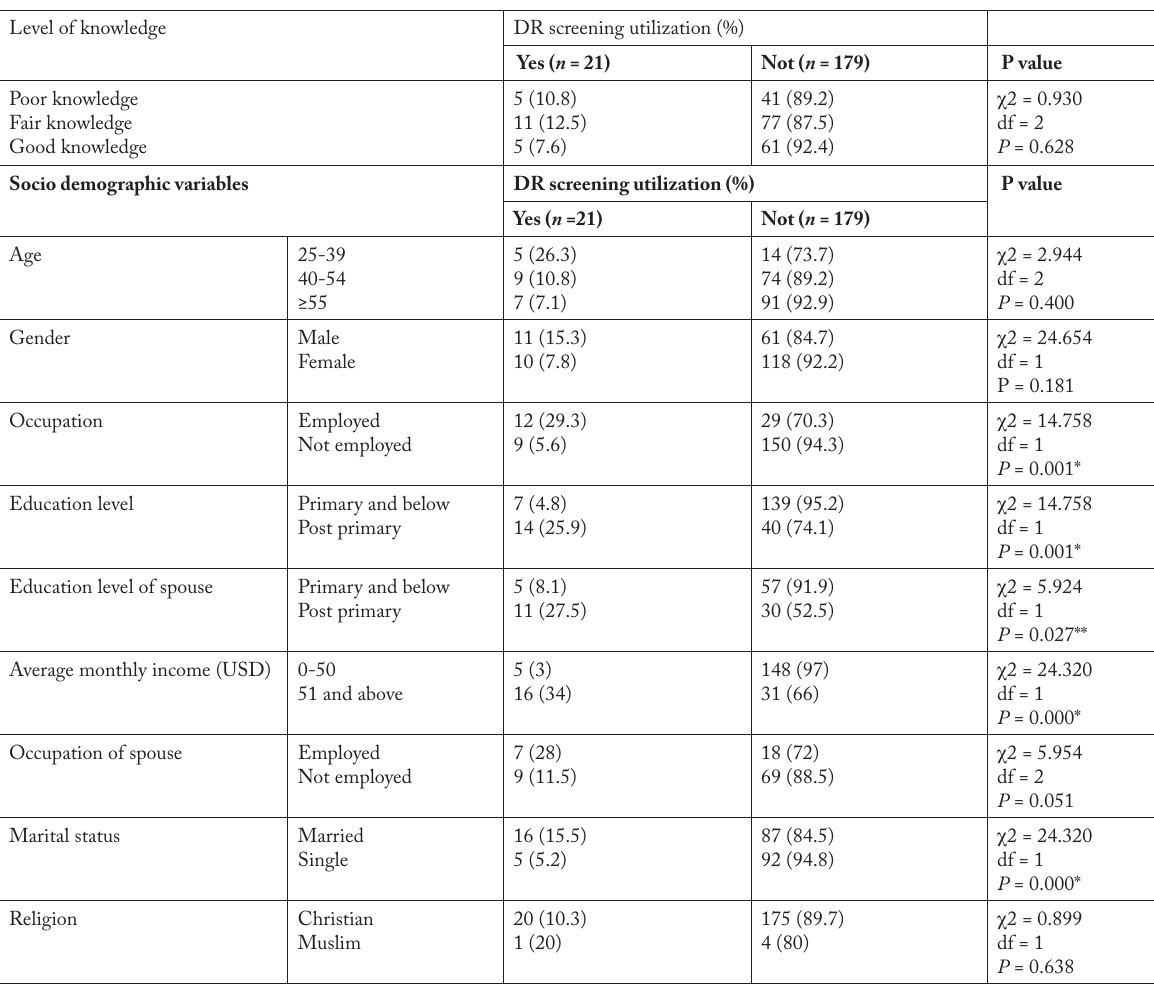
Table 4. Association between level of knowledge, socio-demographic and economic factors and utilization of diabetic retinopathy screening amongst the participants ( n = 200).